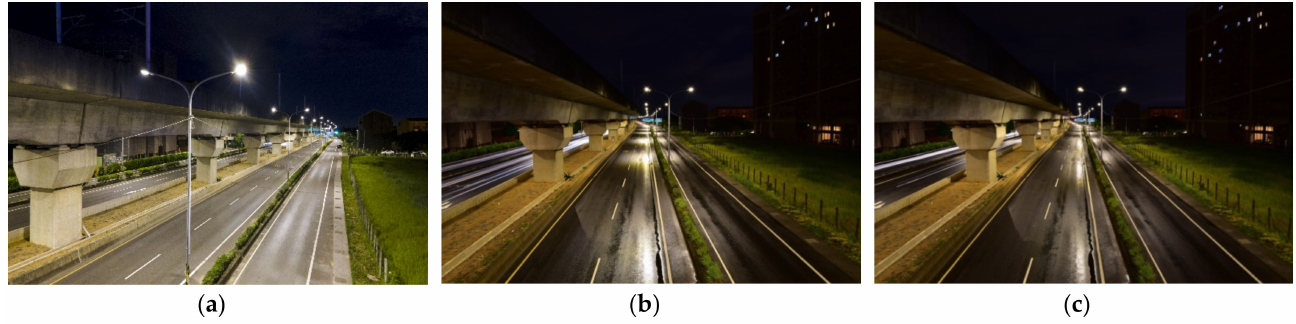
Figure 23. The lighting conditions in Sect. 5 of Gaotie South Road: ( a ) Type A lens on a dry road surface; ( b ) Type A lens on a wet road surface; ( c ) Type B lens on a wet road